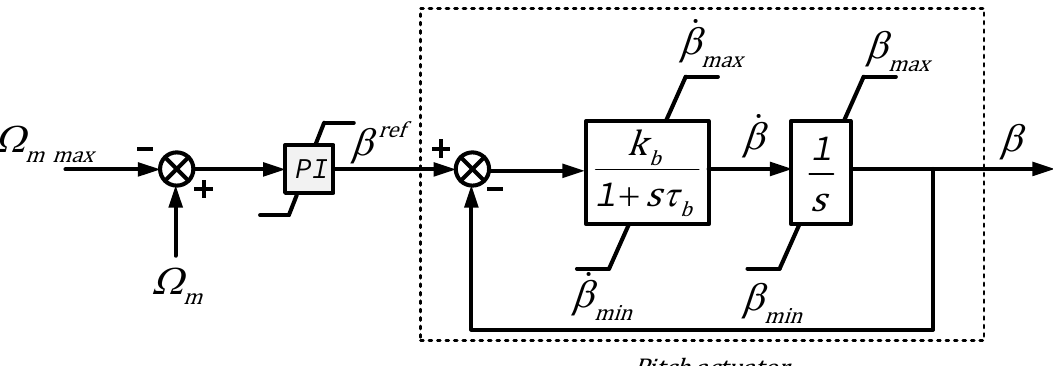
Figure 5. Wind turbine speed control.